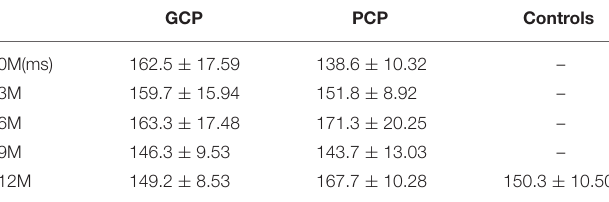
TABLE 2B | The N1 latency across the